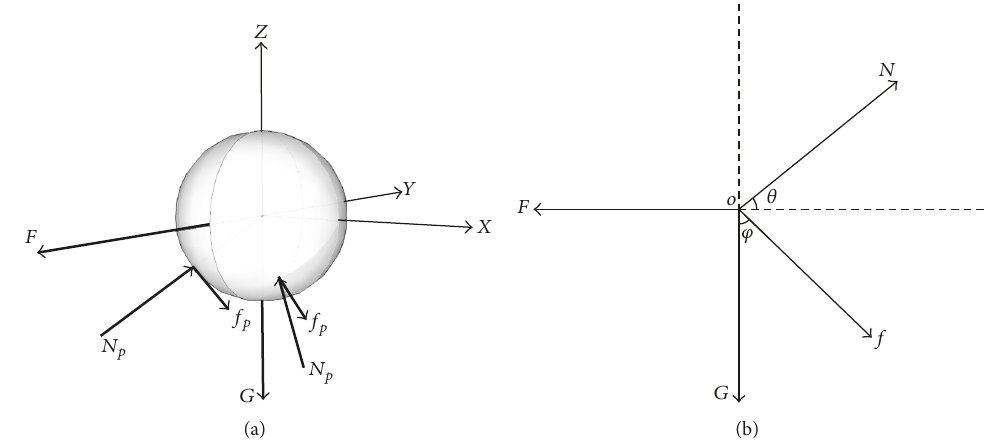
Figure 5: Force analysis of a single spherical soilbag. (a) Three-dimensional graph, Force analysis of a single spherical soilbag. (b) Planar